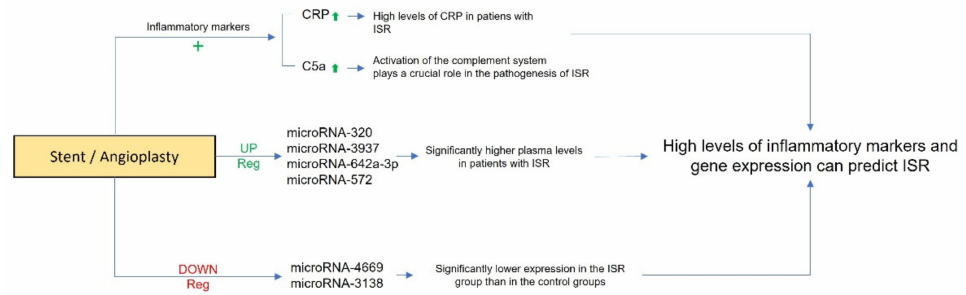
Figure 2. Schematic representation of diagnostic implications of inflammatory markers and microR- NAs in in-stent restenosis. “+” indicates an